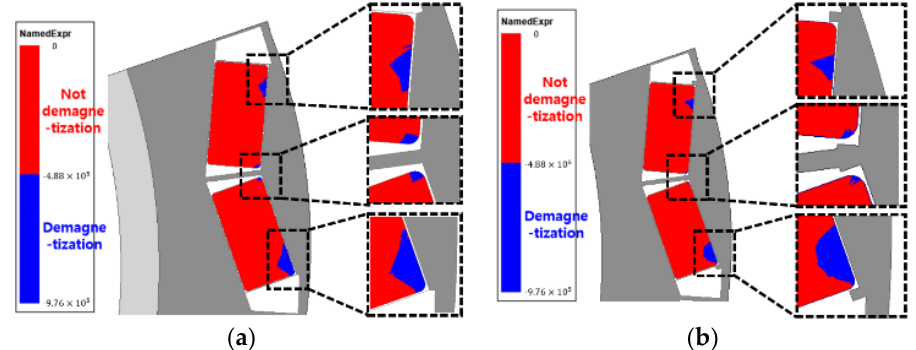
Figure 14. Irreversible demagnetization area before and after inserting steel plates into barriers and bridges: ( a ) before inserting the steel plate; ( b ) after inserting the steel plate.